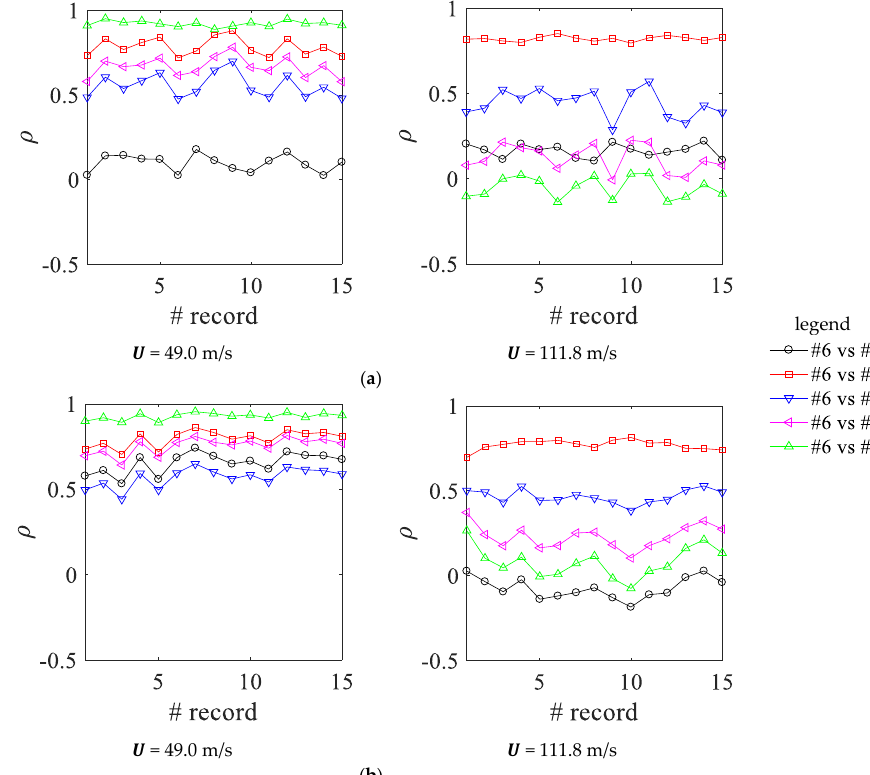
Figure 9. Variability of the correlation coefficient from the building top (i.e., level #6) to levels #1, #2, #3, #4 and #5 along wind ( a ) and across wind ( b ).